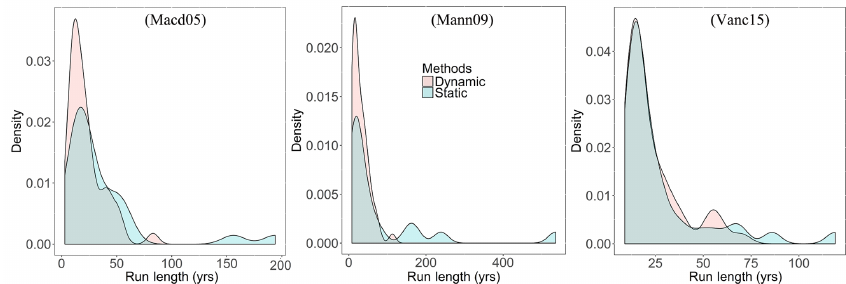
Figure 3. Comparison of run length distributions extracted using the dynamic and static threshold methods in reconstructions with centennial trends.